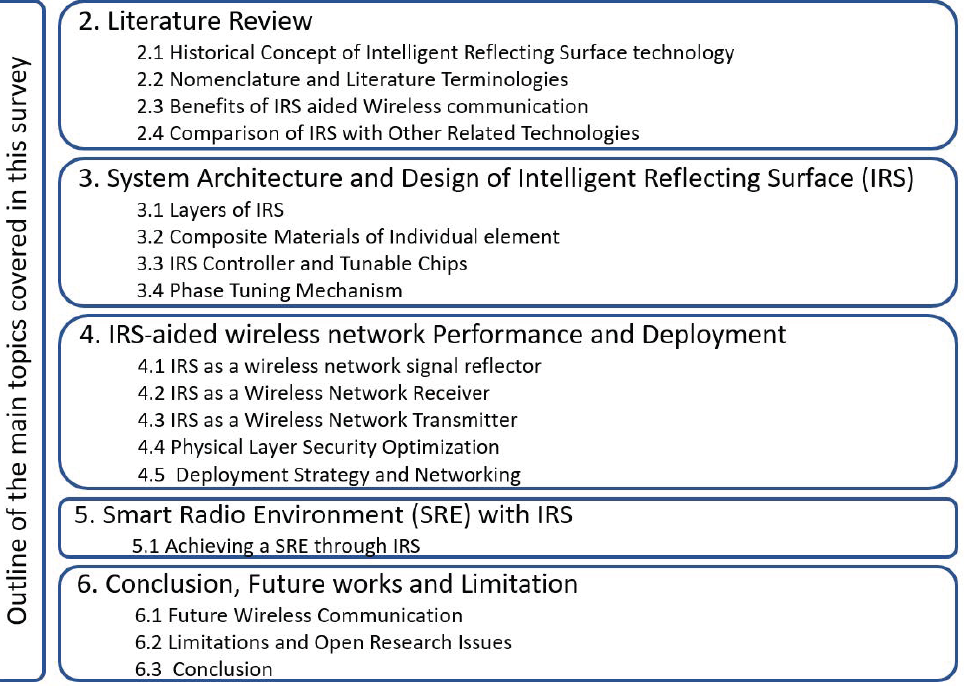
Figure 1. Outline of the covered